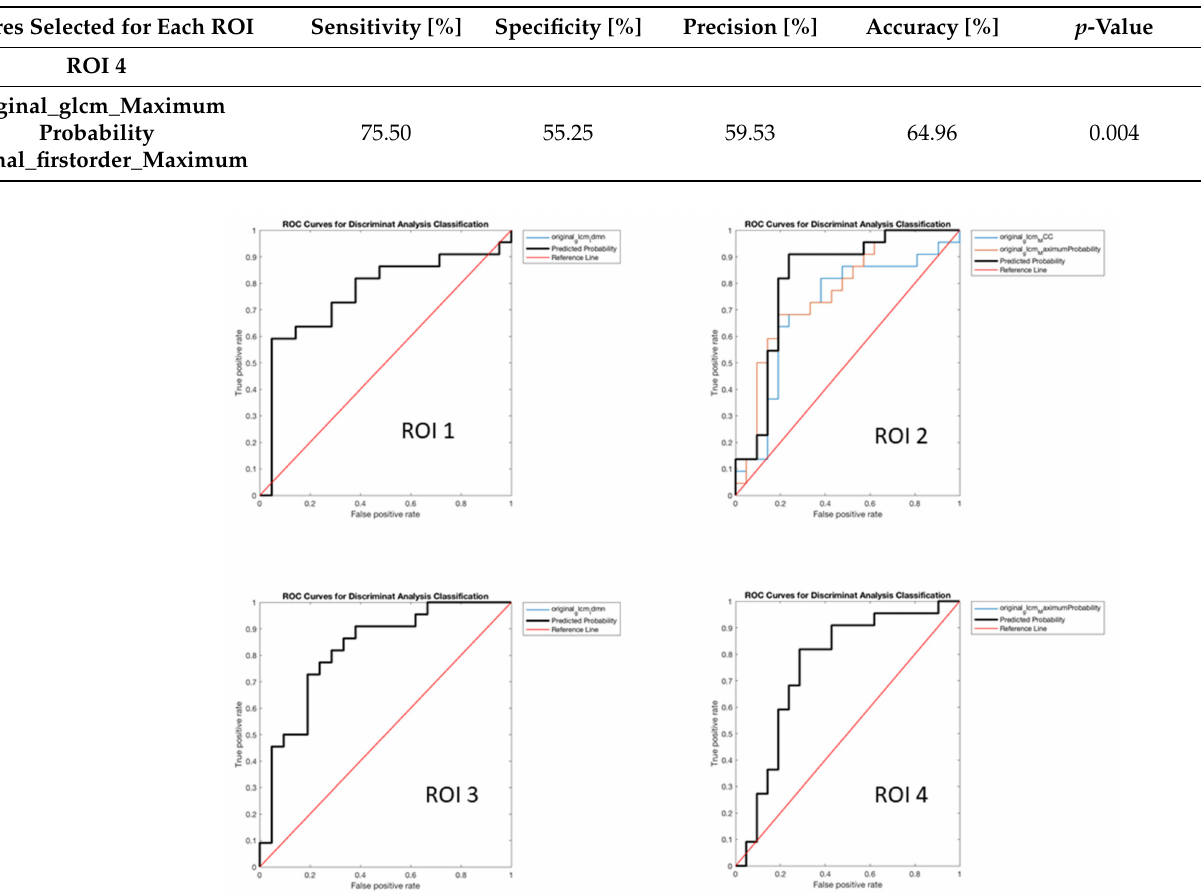
Figure 3. AUROC Curves of FDG-PET derived features in the prediction of